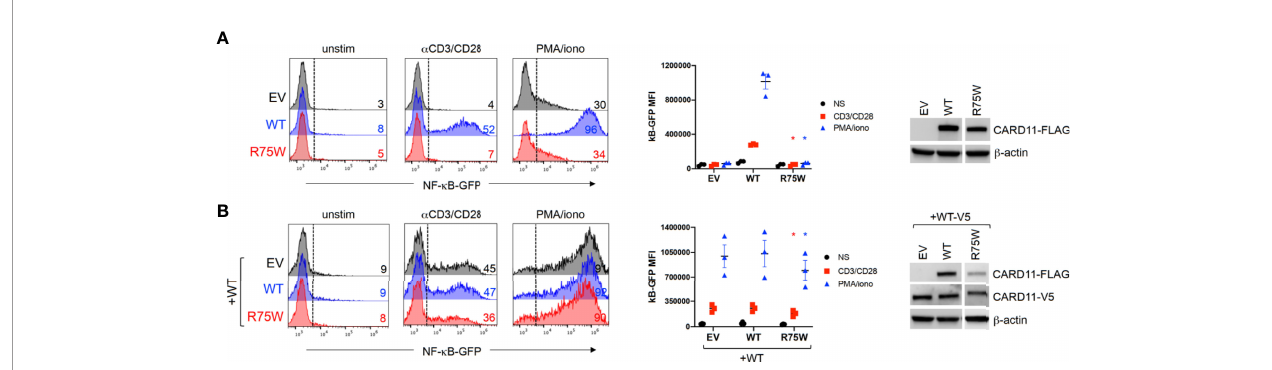
FIGURE 4 | Functional testing of R75W CARD11. JPM50.6 cells were transfected with EV, WT or R75W CARD11-FLAG expression constructs, without (A) or with (B) a WT CARD11-V5 construct. After 24 hrs, transfectants were stimulated with anti-CD3/CD28 Abs or PMA/ionomycin for 24 hrs, and GFP expression was measured by fl ow cytometry. Histograms from one representative experiment (left panels) denote %GFP+ cells -/+ stimulation. Mean fl uorescence intensity (MFI) of GFP+ cells was graphed for 3 independent experiments (middle panels); asterisks denote statistically signi fi cant decreases in GFP MFI for R75W relative to WT -/+ WT CARD11-V5 (paired t-test, p < 0.04). CARD11 protein expression was measured in cell lysates by immunoblotting; b -actin serves as a loading